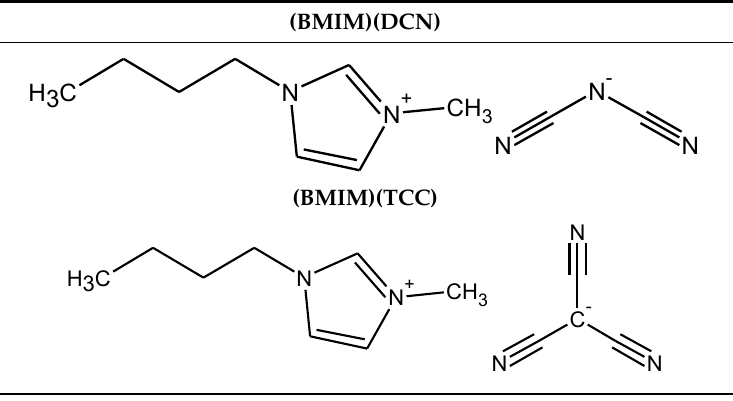
Table 2. Physical properties of the ionic liquids.